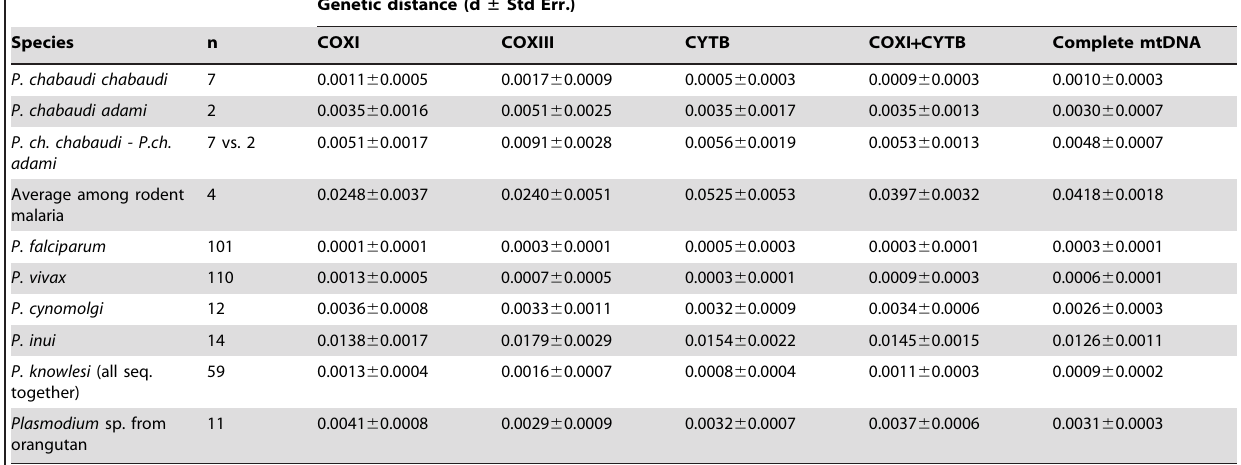
Table 1. Genetic divergences among different Plasmodium species.